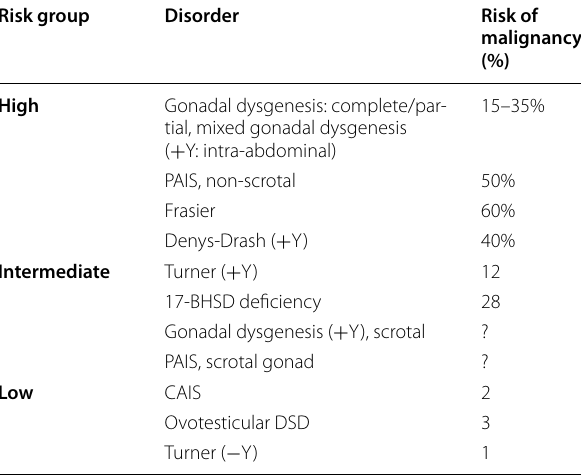
Table 7 The risk of gonadal malignancy associated with various types of